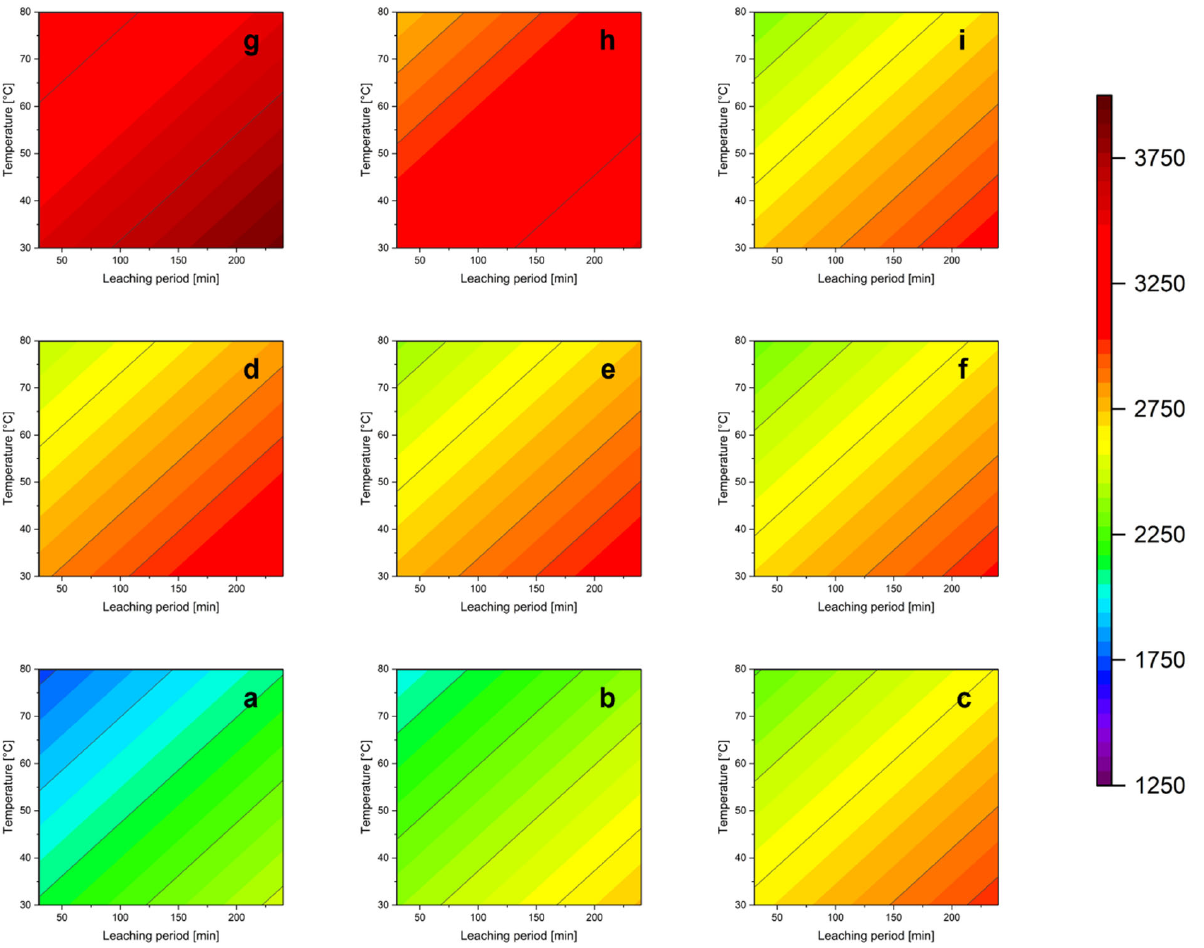
Figure 5. Statistical evaluation of the lithium content in mg · L − 1 for an S/L ratio of 100 g · L − 1 as a function of temperature, leaching time, acid, and oxidizing agent concentration (( a ): 0.3 MH 2 SO 4 , 0 vol% H 2 O 2 , ( b ): 0.3 MH 2 SO 4 , 7.5 vol% H 2 O 2 , ( c ): 0.3 MH 2 SO 4 , 15 vol% H 2 O 2 , ( d ): 1.15 MH 2 SO 4 , 0 vol% H 2 O 2 , ( e ): 1.15 MH 2 SO 4 , 7.5 vol% H 2 O 2 ; ( f ): 1.15 MH 2 SO 4 , 15 vol% H 2 O 2 , ( g ): 2 MH 2 SO 4 , 0 vol% H 2 O 2 ,